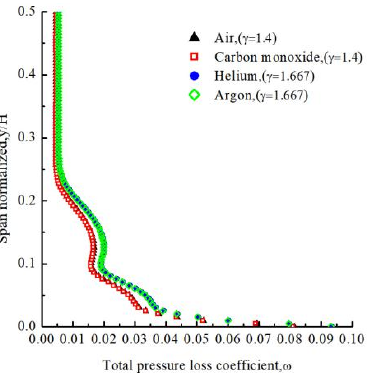
6 of 14 Figure 3. Predicted and experimental static pressure on blade surfaces for different turbulence models.